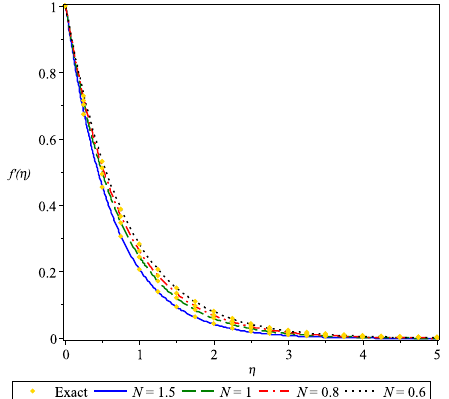
Figure 1. Dependency of velocity profile f (cid:48) on the magnetic parameter N when Sc = 0.24 and K = 0.2 and comparison between the result of RGC method and the exact